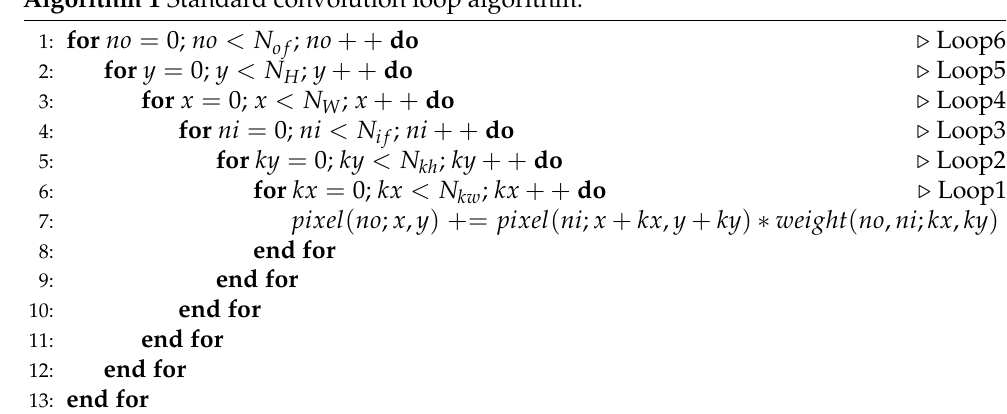
Algorithm 1 Standard convolution loop